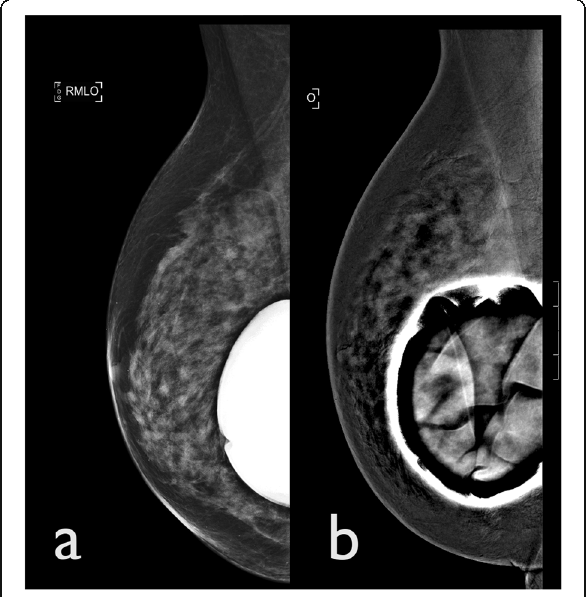
Fig. 8 Breast implant artefact. A CEDM was performed for suspected microcalcifications in a 55-year-old woman with a right breast implant. a LE CEDM image shows a breast implant in situ. b CEDM recombined image presents a significant post-processing artefacts secondary to the presence of the